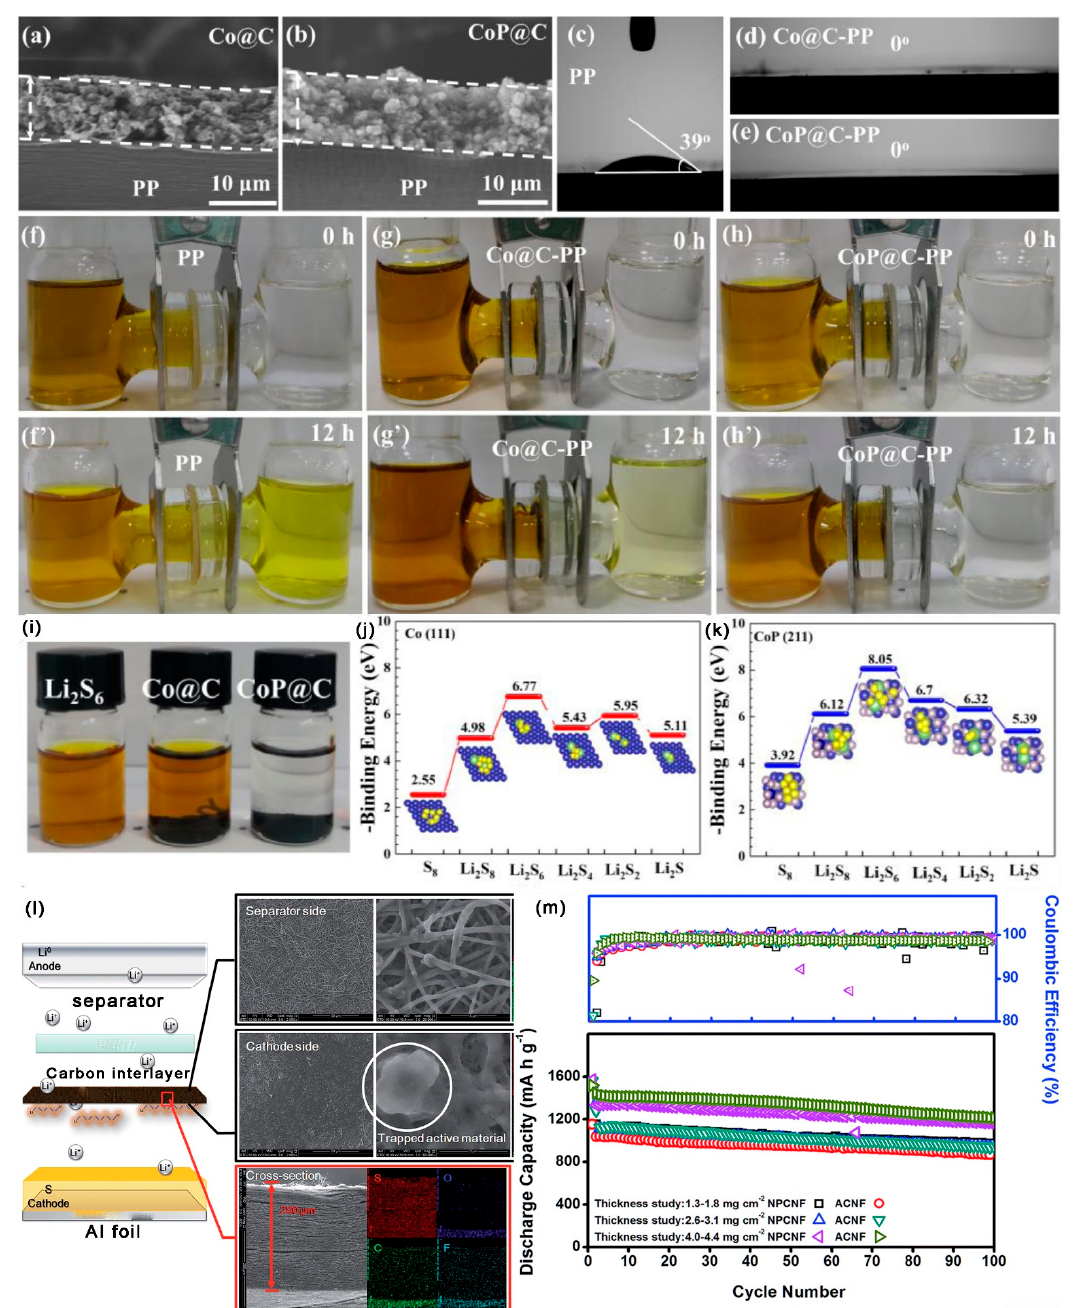
Figure 20. SEM images of separators with ( a ) Co@C coating and ( b ) CoP@C coating. Contact angles of separators with ( c ) blank, ( d ) Co@C coating, and ( e ) CoP@C coating. Experiments on H-shaped permeation devices of separators with ( f , f ’) blank, ( g , g ’) Co@C coating, and ( h , h ’) CoP@C coating. ( i ) The optical images of the CoP@C-containing Li 2 S 6 solution adsorption experiments. The adsorption energies of the S-containing substance on ( j ) Co (111) and ( k ) CoP (211) [148]. ( l ) SEM and EDS mapping showed how the ACNF interlayer captured LiPSs. ( m ) Cycling performance of LSBs with ACNF interlayer